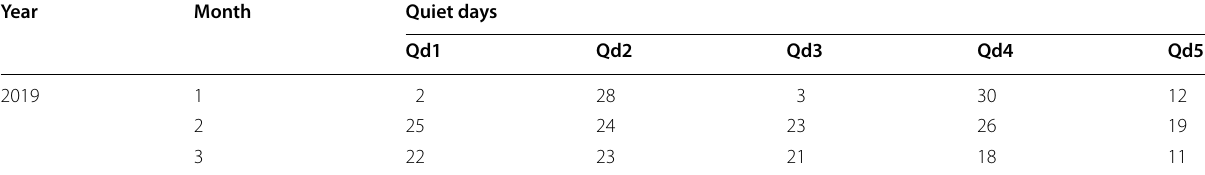
Table 3 List of five most quiet days from January to March in 2019